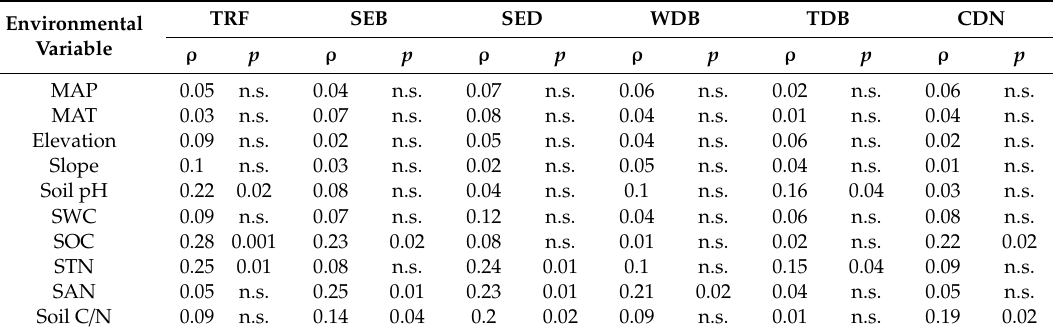
Table 2. Correlations of soil fungal β -diversity with environmental distance (averaged at the plot level) from Mantel tests in six forest types.